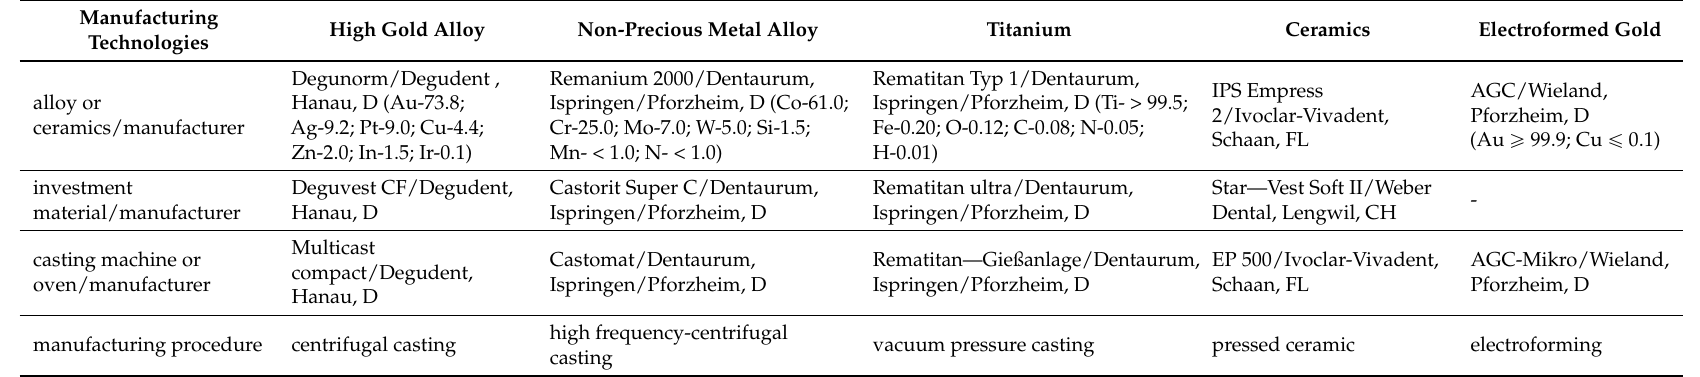
Table 2. Summary of the devices and materials used, including the components of the alloys (in percent by